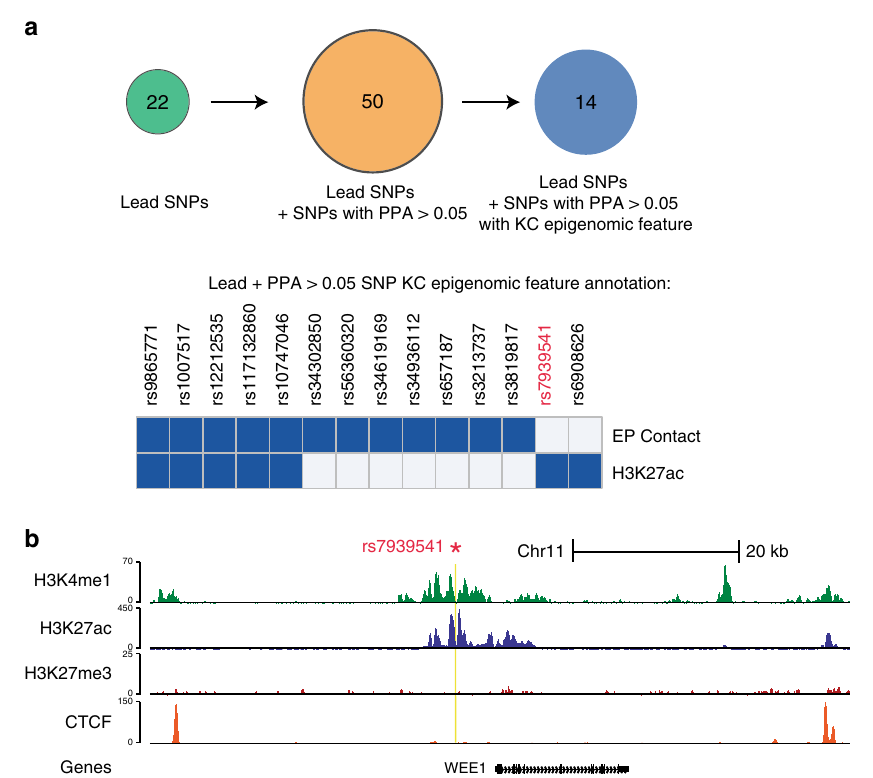
Fig. 3 Annotation of novel SNPs with epidermal enhancer information. a Top: Circles represent the number of SNPs considered at each stage of the work fl ow to identify epigenetic context of all novel SNPs. We started with 22 lead SNPs identi fi ed by meta-GWAS, then found putative causal SNPs de fi ned as any SNPs with a PPA of >0.05 from our fi ne-mapping analysis. We next re fi ned that expanded list to SNPs for which the genomic location overlapped a previously identi fi ed epigenomic feature (either the H3K27ac enhancer mark or ends of an enhancer – promoter contact). Bottom: Heatmap displaying the overlap of SNPs with enhancer – promoter contacts or H3K27ac marked regions. The blue designation indicates that the SNP overlaps at least one H3K27ac region or contact. b Genome browser tracks for the genomic locus for SCC-index SNP rs793954, PPA > 0.99, demonstrating enhancer features in primary human keratinocytes (KC). ChIP-seq signal tracks are displayed for H3K4me1 and H3K27ac (which typically mark active enhancers and promoters) as well H3K27me3 (which marks inactive loci). Yellow denotes SNP location; note this SNP falls in a region marked by H3K27ac and H3K4me1 enhancer- associated histone marks, with lack of the repressive H3K27me3 mark. CTCF sites indicate that the SNP is not involved in CTCF loops and associated